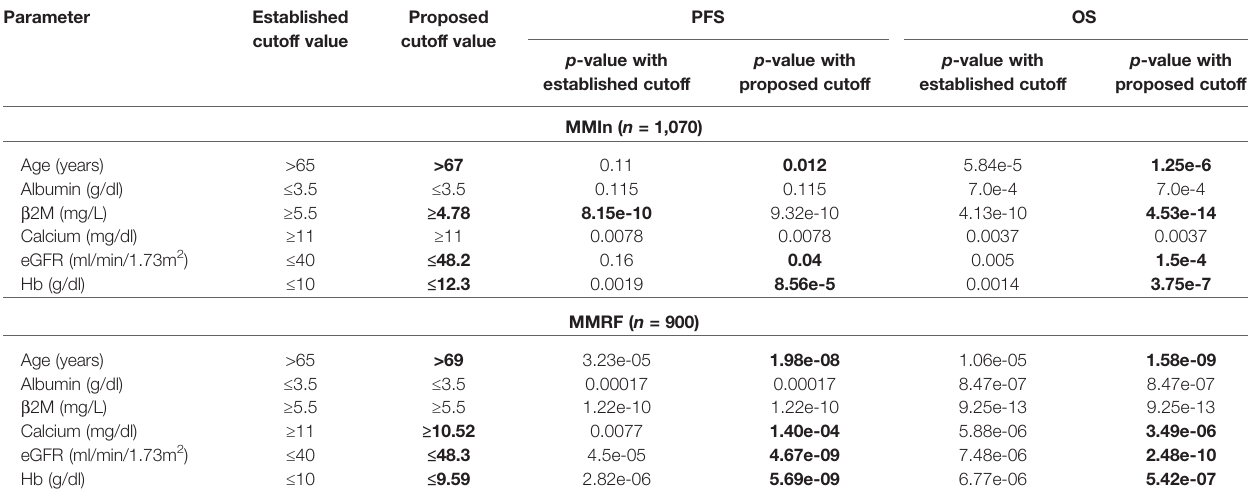
TABLE 1 | Comparison of established and proposed cutoffs for clinical and laboratory parameters for the strati fi cation of patients for progression-free survival (PFS) and overall survival (OS) in MMIn and MMRF using Kaplan – Meier analysis. Parameter Established cutoff